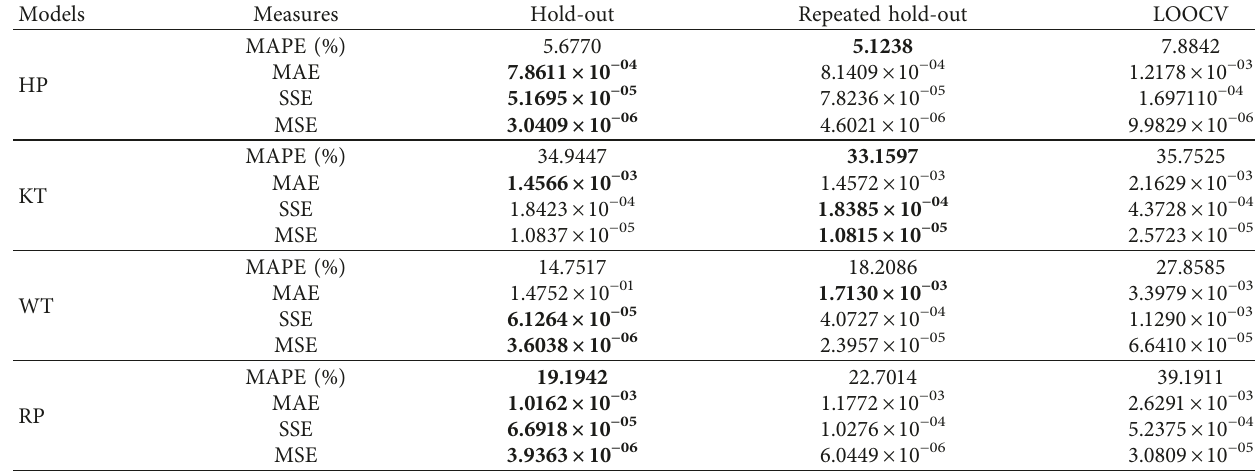
Table 7: Results of the goodness-of-fit measures for the men’s mortality.